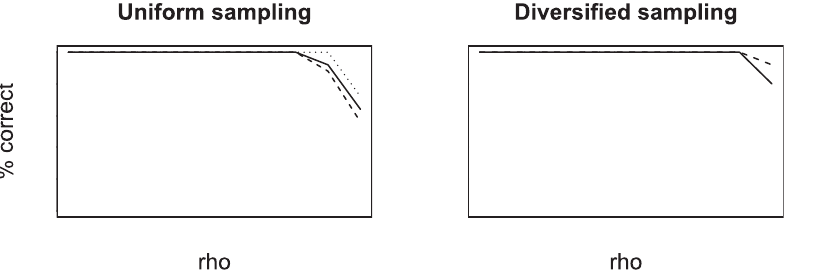
Figure 6. The sensitivity analysis testing whether the sampling strategy can be inferred. Trees were simulated under three different models: constant-rate pure birth (solid line), decreasing rate pure birth (dashed line) and constant-rate birth-death (dotted line). The x-axis shows simulations for different sampling probabilities r .